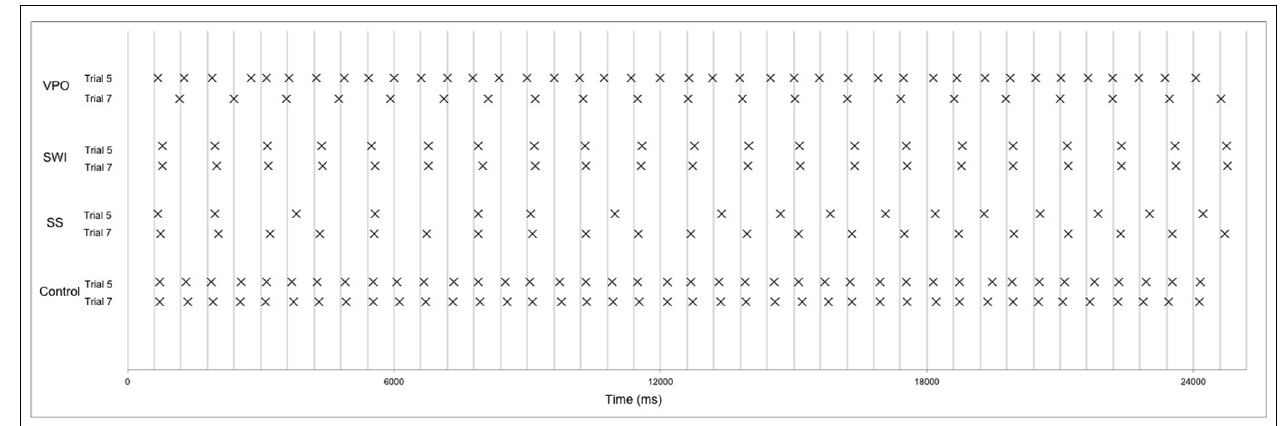
FIGURE 6 | Raw tapping data inTrial 5 andTrial 7 for dysrhythmics and one control subject (randomly selected). Lines give the correct tap times, and the midpoint of each × represents an individual tap.Taps corresponding to the first 40 tones are given